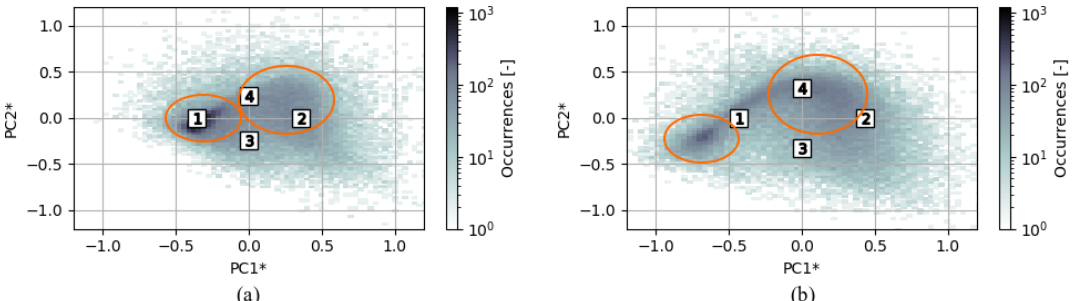
Figure 4. Sample frequency distributions in the PC1, PC2 space for the offshore (a) and onshore (b) locations. The origins coincide with the mean wind profile shapes and the markers with the wind profile shapes numbered 1–4 in Figs. 2 and 11. The orange ellipses indicate the visually identified clusters. The plots share the same coordinate system with the x axis ( y axis), aligned with the average of the PC1 (PC2) unit vectors from the two reference locations. The averaged PCs are denoted by an asterisk and their profiles shown in Figs. 2 and 11 (b, f) .